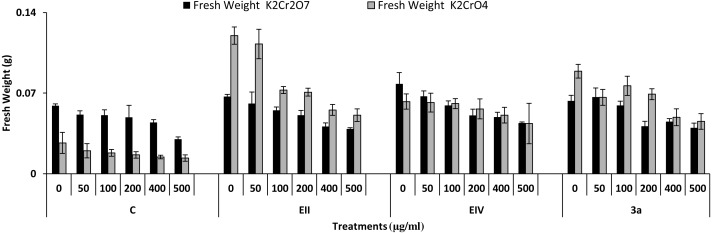
Effect of bacterial inoculations (K2Cr2O7 and K2CrO4 (0–500 µgml−1)) on fresh weight (g) of Lens culinaris (C, without bacterial inoculation; EII, EIV and 3a, bacterial isolates).